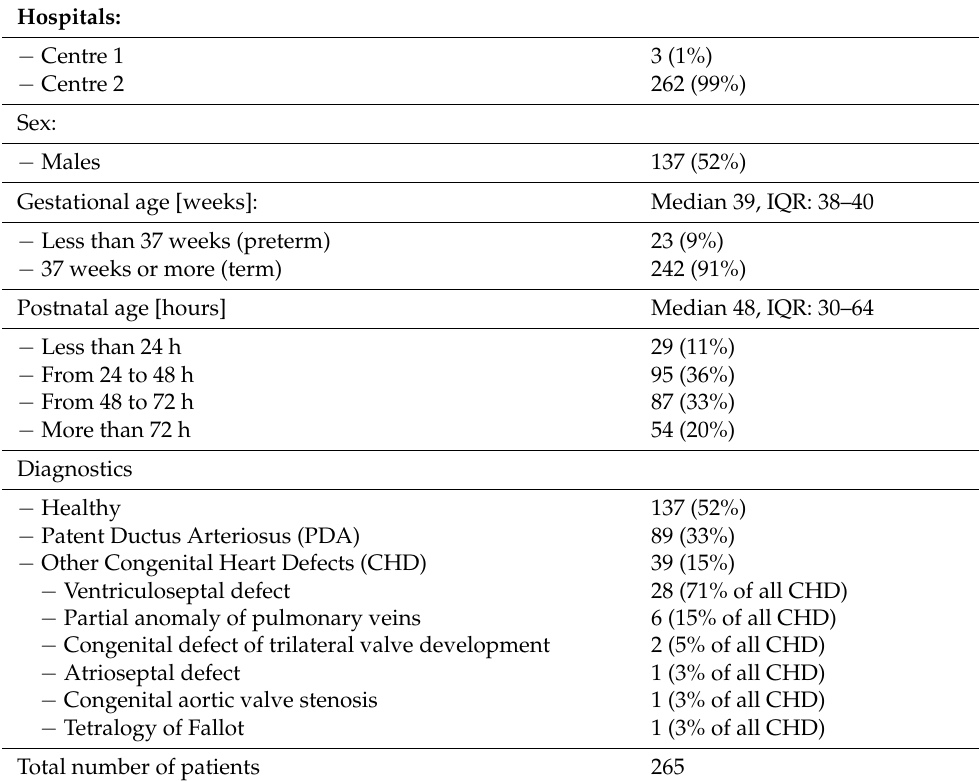
Table 1. Demographic breakdown of the dataset (N =